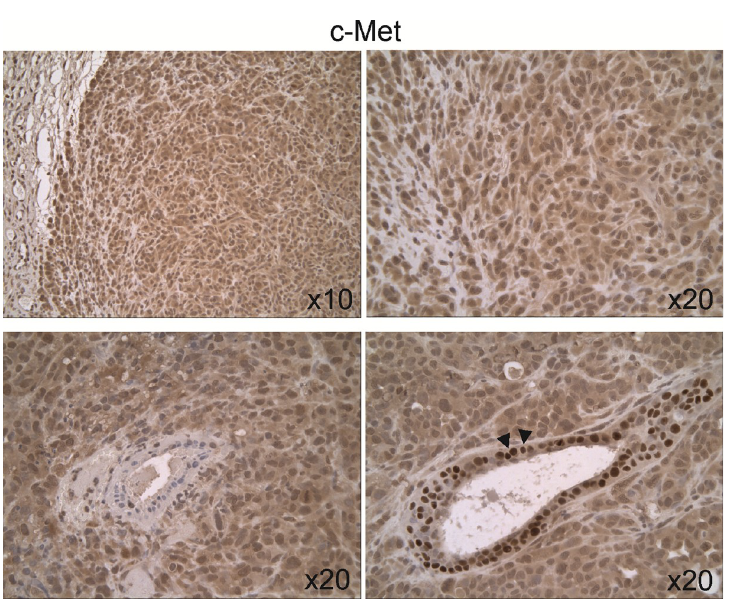
Fig 5. Expression and cellular distribution of c-Met in untreated 231/LM2-4 tumor xenografts. c-Met staining was relatively homogenous throughout the tumor tissue, and was both cytoplasmic and nuclear. Hyperplastic acini showed cytoplasmic and nuclear staining, with strong staining in the nucleus (down-right arrows).